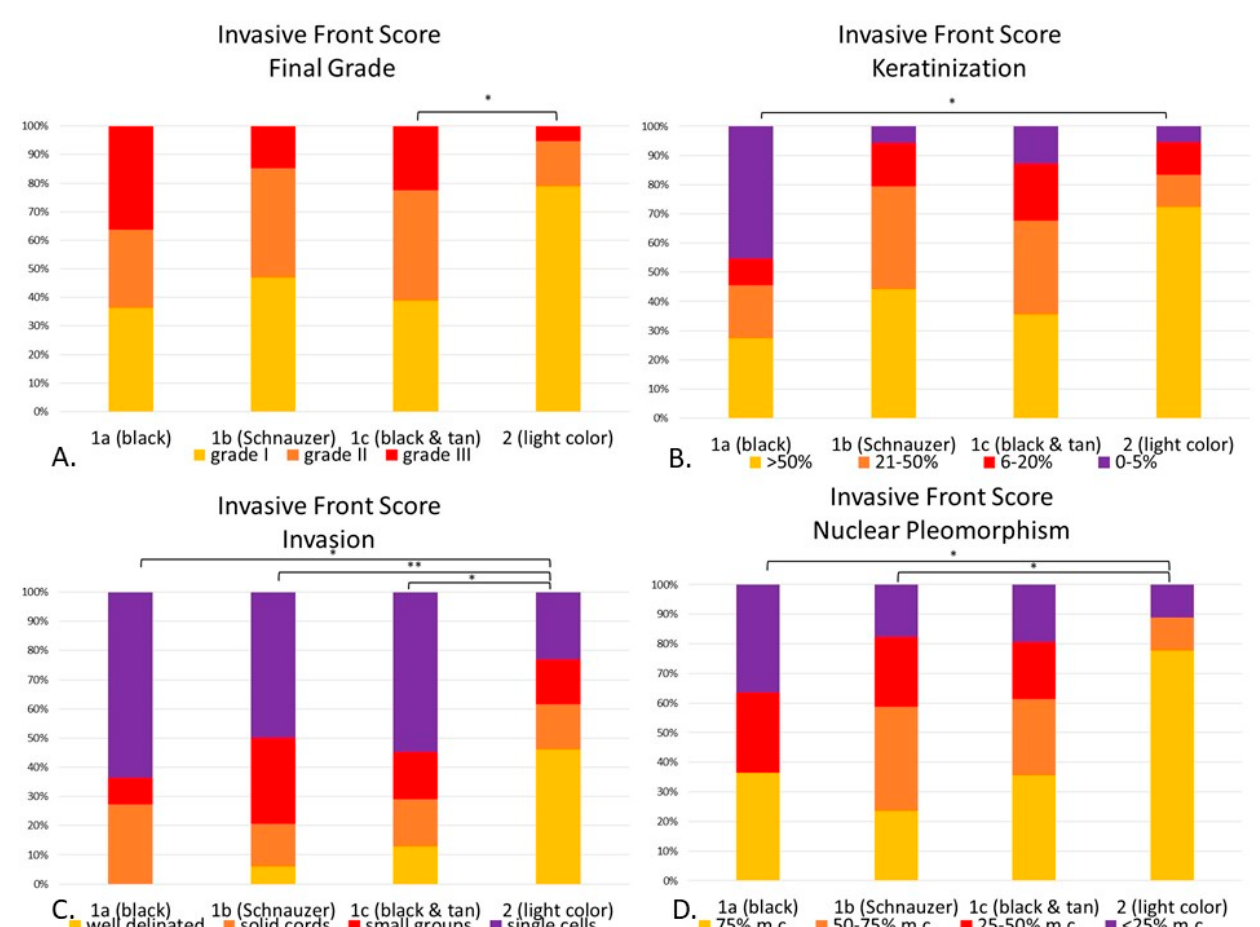
Figure 8. ( A – D ). Canine digital squamous cell carcinoma. Statistical differences between genetically defined subgroups (1a–c) and Group 2 according to the invasive front grading system. Invasive front final grade ( p < 0.05), with statistical differences between Group 1c and 2 ( A ). Keratinization ( p < 0.05) with differences between 1a and 2 ( p < 0.05) ( B ). Invasion ( p < 0.01) with significant differences between 1a ( p < 0.05), 1b ( p < 0.01) and 1c ( p < 0.05) when compared to 2. ( C ). Nuclear pleomorphism ( p < 0.05) with significant differences between 1a ( p < 0.05) and 1c ( p < 0.05) when compared with Group 2. ( D ). * p < 0.05; ** p < 0.01. Abbreviations: m.c.: mature cells.